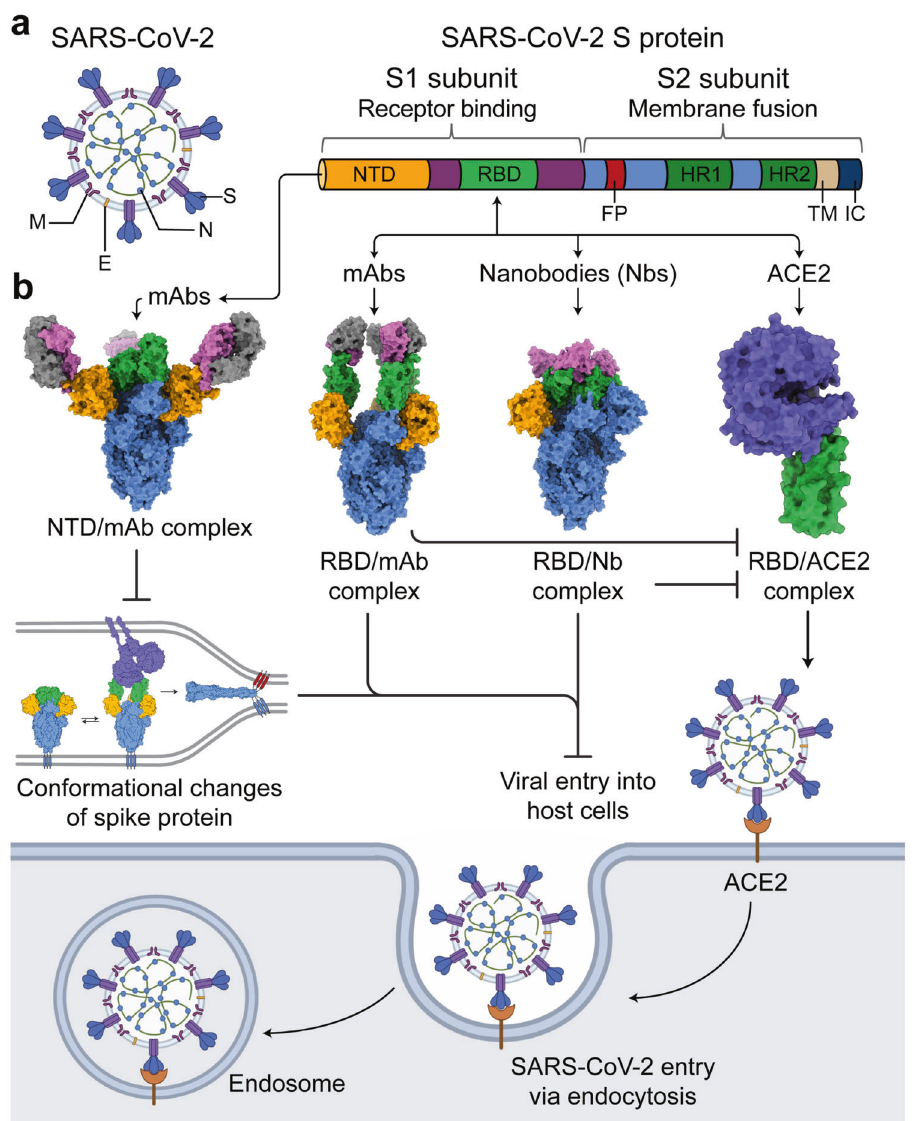
Fig. 1 SARS-CoV-2 spike (S) protein is a key target for eliciting neutralizing antibodies. a Schematic structures of SARS-CoV-2 virion and its S protein. M, membrane; E, envelope; N, nucleocapsid. Viral RNA is located inside the virion. NTD, N-terminal domain; RBD, receptor-binding domain; FP, fusion peptide; HR1 and HR2, heptad region 1 and 2; TM, transmembrane domain; IC, intracellular tail. b Mode of action of SARS- CoV-2 S-speci fi c neutralizing antibodies. Monoclonal antibodies (mAbs) targeting S protein NTD prevent conformational changes of the S protein that are required for S2-mediated membrane fusion, and hence inhibit viral entry into host cells. RBD-targeting neutralizing mAbs or nanobodies (Nbs), on the other hand, bind directly to SARS-CoV-2 S protein RBD and compete with the cellular receptor, angiotensin converting enzyme 2 (ACE2), resulting in neutralization of viral infection and clearance of the virus. The following PDB entries are used for structural illustrations: 7C2L (structure of SARS-CoV-2 S in complex with NTD-targeting mAb 4A8), 7K4N (structure of SARS-CoV-2 S in complex with RBD-targeting mAb S2E12), 7KKK (structure of SARS-CoV-2 S in complex with RBD-targeting nanobody Nb6), and 6VW1 (structure of SARS-CoV-2 RBD in complex with human ACE2). SARS-CoV-2 S NTD is colored in orange, RBD in green, and the rest part of S protein in light blue. ACE2 is colored in purple. This fi gure was prepared using BioRender (https://biorender.com/) and UCSF ChimeraX (https://www.cgl.ucsf. edu/chimerax/) of SARS-CoV, thereby cross-neutralizing SARS-CoV infection; antibodies show cross-reactivity and/or cross-neutralizing activity however, they show low to no cross-reactivity with low- against other coronaviruses. Some studies indicate that SARS-CoV- pathogenic human coronaviruses such as HKU1, 229E, OC43, or 2 RBD-speci fi c IgG antibodies are present in convalescent plasma NL63. 4,5 Considering the high sequence similarity between SARS- from COVID-19 patients, and that IgG antibodies speci fi c for RBD and S (ectodomain) correlate positively with anti-SARS-CoV-2 CoV-2, SARS-CoV, and other SARS-like coronaviruses, and their use neutralizing antibody titers. 3 Other studies demonstrate the of the same ACE2 receptor, further studies are needed to understand whether antibodies generated by SARS-CoV-2- generation of persistent, but slightly reduced, IgG antibodies in infected patients cross-react with S proteins or their fragments patients with COVID-19; these antibodies also target SARS-CoV-2 (S1-RBD/S2), and/or cross-neutralize infections by SARS-like RBD, and the titers correlate with S-speci fi c neutralizing antibody coronaviruses with pandemic potential. titers. 4 Moreover, these antibodies may cross-react with the S/RBD Signal Transduction and Targeted Therapy (2021)